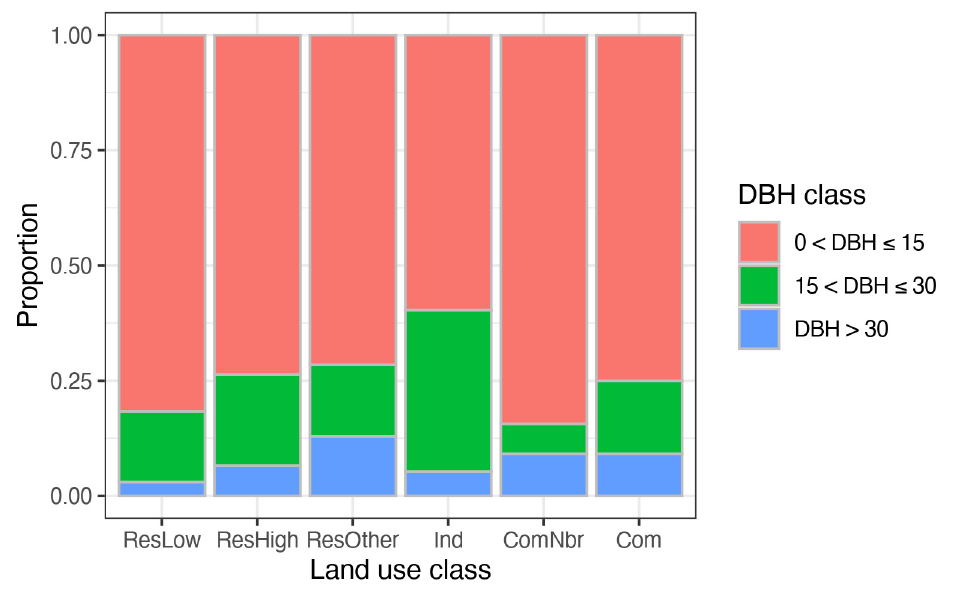
Figure 2. DBH (diameter at breast height) distribution across land use classes.